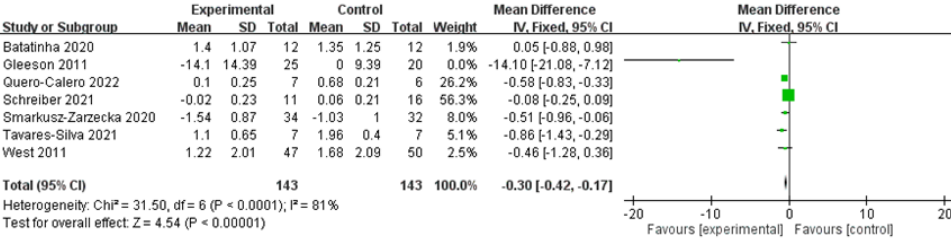
Figure 3. Outcomes for tumor necrosis factor (TNF) −α , indicating that the probiotic group exhibited a significant negative change. An outlier study was noted. The effect size for various modes and sites of stimulation is presented in Table 2. Table 2. Overall effect of inflammation-related